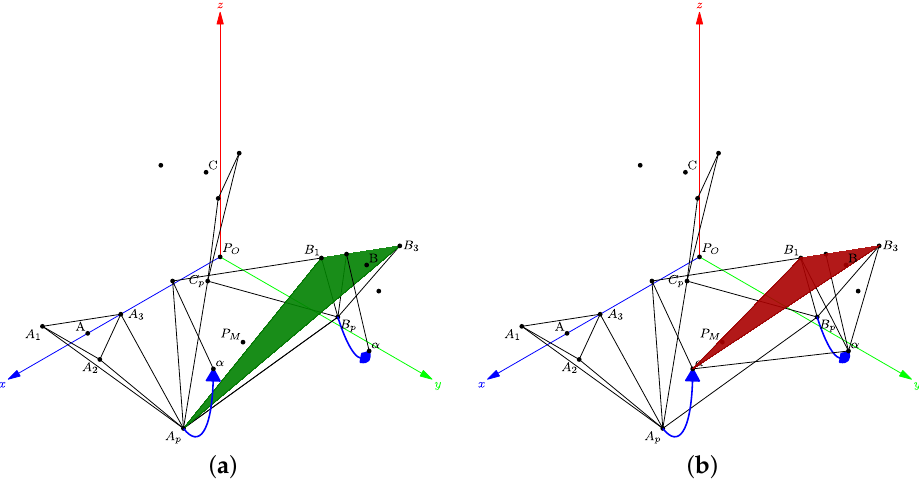
Figure 11. Rotation of α angle about the axis B 1 − B 3 : ( a ) original tetrahedron, T B ( b ) rotated tetrahedron. There are two possible apex values: Bps 1 over, and Bps 2 below of the XY plane. We show the Bpr apex below the XY plane in Figure 12.